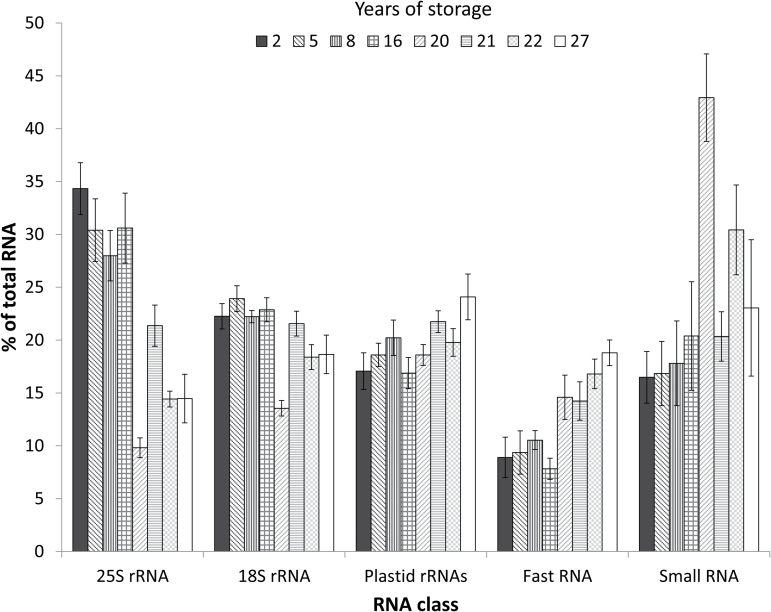
Seed aging effects on the size of RNA fragments. Each bar represents the percentage of the peak area within an RNA class compared with the total peak area for soybean seeds from eight different age cohorts (2014, 2 years of storage; 2011, 5 years of storage; 2008, 8 years of storage; 2000, 16 years of storage; 1996, 20 years of storage; 1995, 21 years of storage; 1994, 22 years of storage; 1989, 27 years of storage). Error bars represent the SE within age cohorts; the number of RNA extractions ranged from seven to nine per cohort (number of seeds=4 or 5).